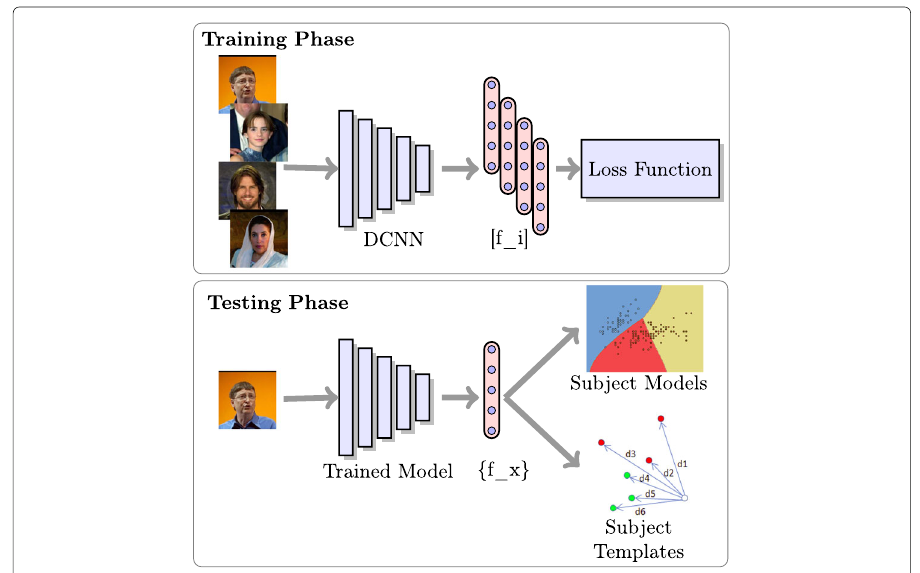
Fig. 1 The dataflow of a deep face recognition system. During training the network learns feature representations (f_i) of faces by getting gradually penalized by the loss function. During testing, the pre-trained model is used to generate features of test faces. The generated features are classified/compared for identity